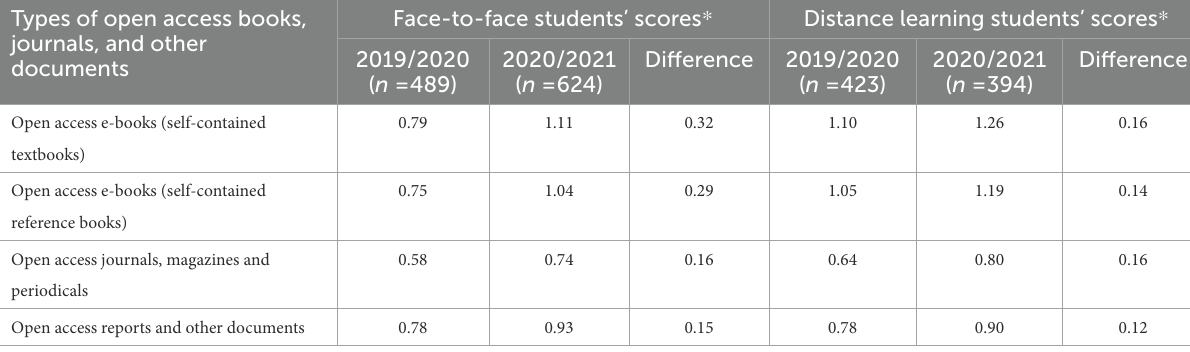
TABLE 4 Usefulness of various types of open access e-books, journals, reports, and other